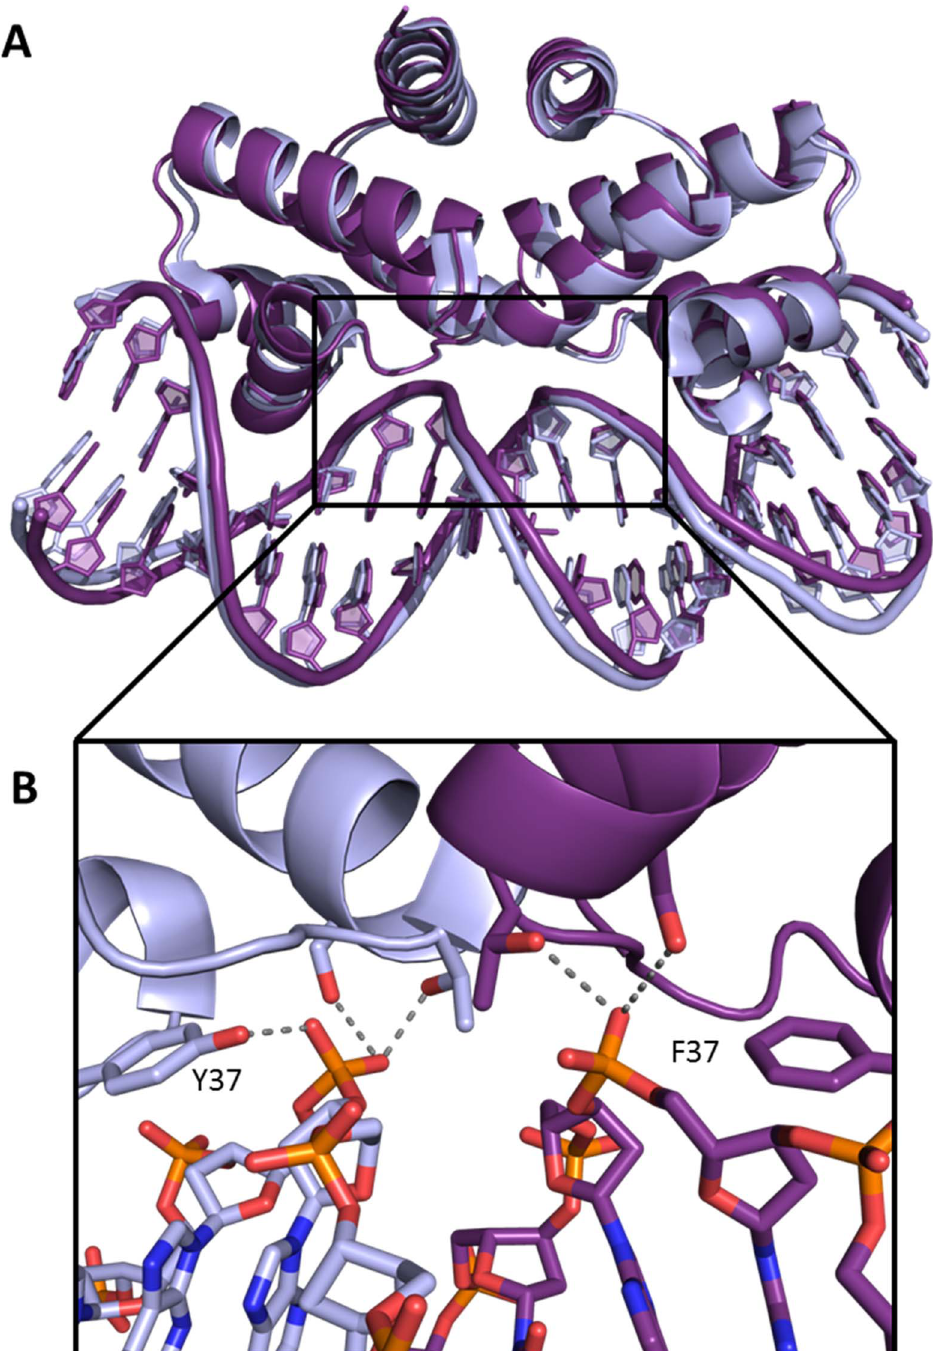
Figure 7. Comparison of the wild-type and Y37F mutant 19O M co-crystal structures. The wild type structure is shown in pale blue and the Y37F mutant structure in purple. (A) An overlay of the two structures shows the high degree of similarity between the two. (B) The DNA ‘‘pinching’’ point at the central TATA sequence. Hydrogen bonds are shown as grey lines. doi:10.1371/journal.pone.0098365.g007 From the Y37F-19O M co-crystal structure, it is clear that the differences either in the local binding regions in terms of helix or side chain positions, or in the overall fold. Comparing the native only major alteration to the binding interface is the loss of the and mutant (Y37F) protein-DNA complex structures, the tyrosine hydroxyl - phosphate hydrogen bonds, of which there is one per and the phenylalanine were equally buried and inaccessible to protein subunit. The D G values were calculated from the solvent and in both cases the phenyl ring stacks against the equilibrium binding constants for the wild type, Y37F and Y37A deoxyribose ring in the DNA. proteins binding to DNA to be 2 53.0, 2 49.9 and 2 47.1 kJ mol 2 1